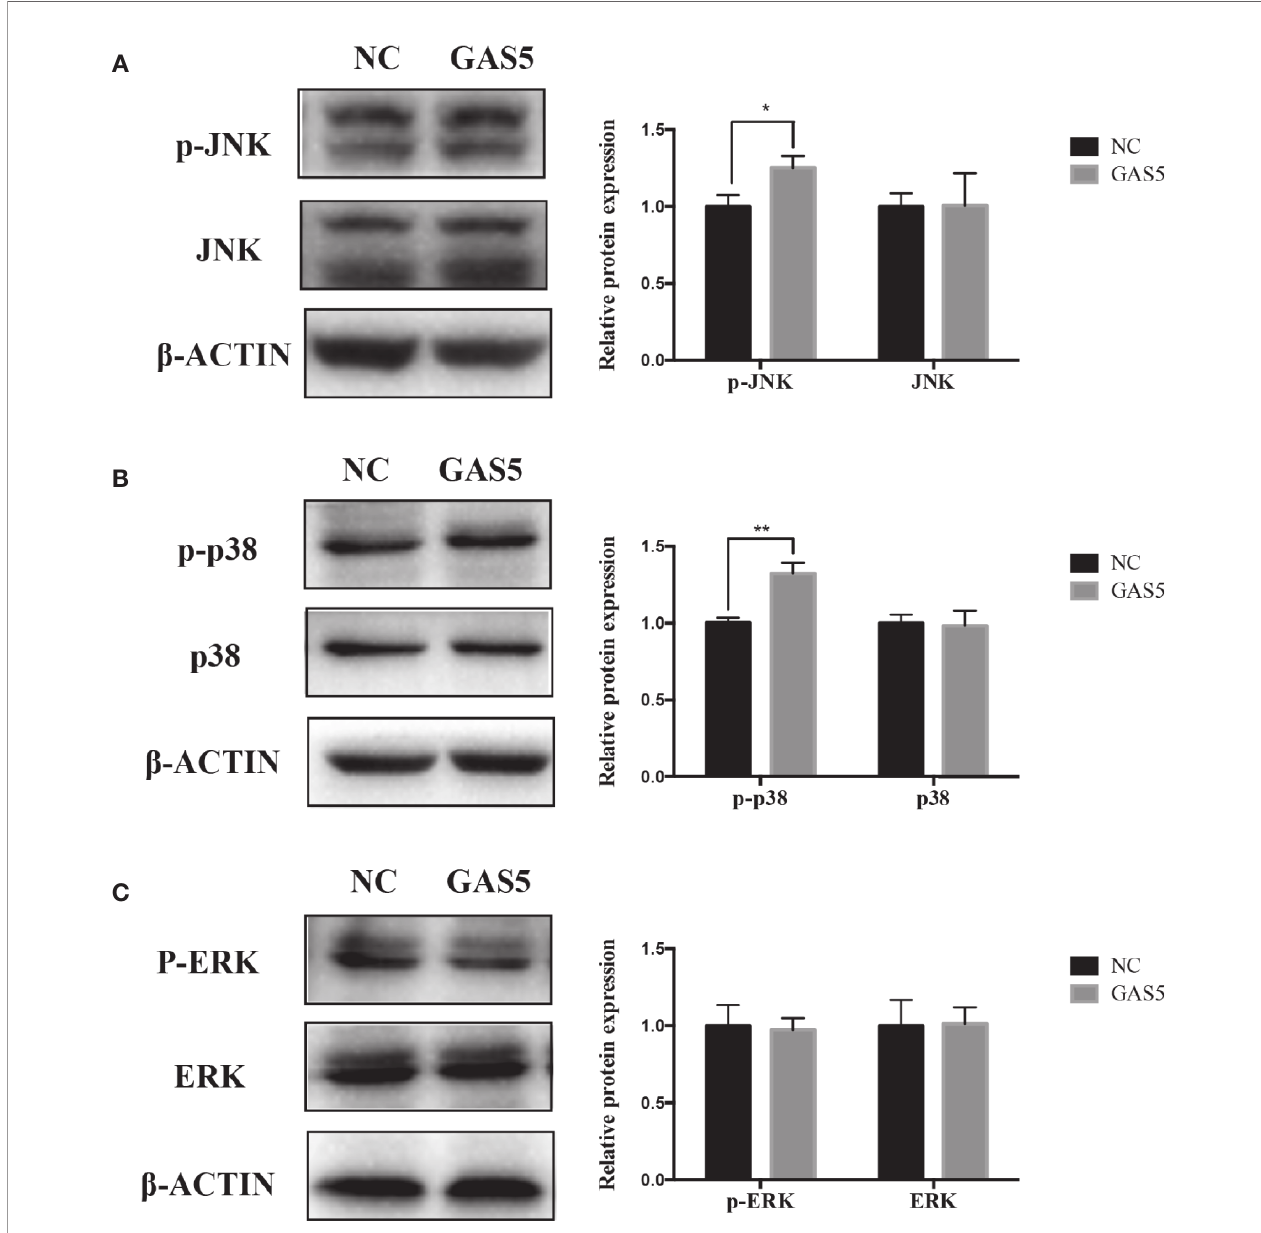
FIGURE 7 | Overexpressing GAS5 enhanced the phosphorylation of JNK and p38 in hPDLSCs. (A) : Western blot analysis of phosphorylated JNK (p-JNK), JNK and b -ACTIN in hPDLSCs transfected with NC or GAS5. Histogram showed the quanti fi cation of the band intensities. (B) : Western blot analysis of phosphorylated p38 (p-p38), p38 mitogen-activated protein kinase (p38), and b -ACTIN in hPDLSCs transfected with NC or GAS5. Histogram showed the quanti fi cation of the band intensities. (C) : Western blot analysis of phosphorylated ERK (p-ERK), ERK and b -ACTIN in hPDLSCs transfected with NC or GAS5. Histogram showed the quanti fi cation of the band intensities. *p < 0.05, **p < 0.01. hPDLSCs, human periodontal ligament stem cells; GAS5, lncRNA growth arrest speci fi c transcript 5; NC, negative control; JNK, c-Jun N-terminal kinase; ERK, intracellular signal-regulated kinase